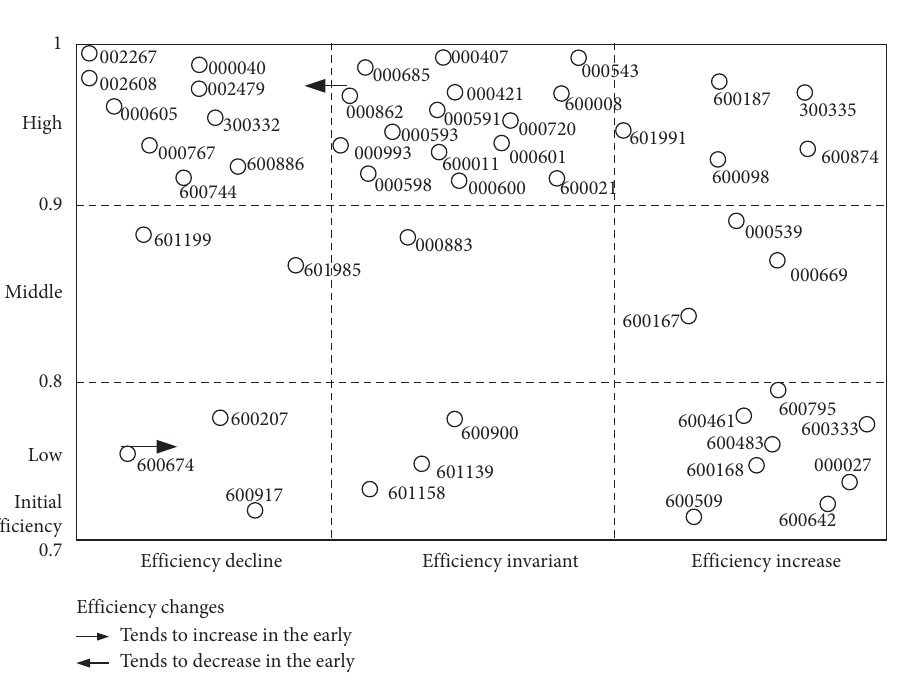
Figure 7: GE matrix of comprehensive efficiency of green innovation of listed energy companies in